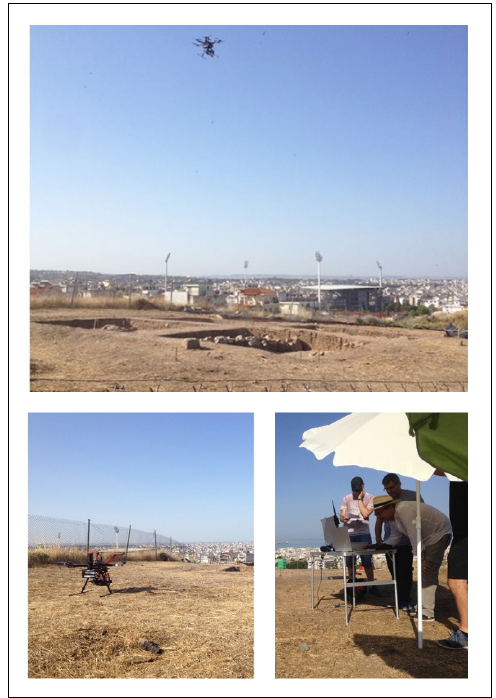
Figure 6 . Τhe autonomous UAV system during the UAV photography campaign.